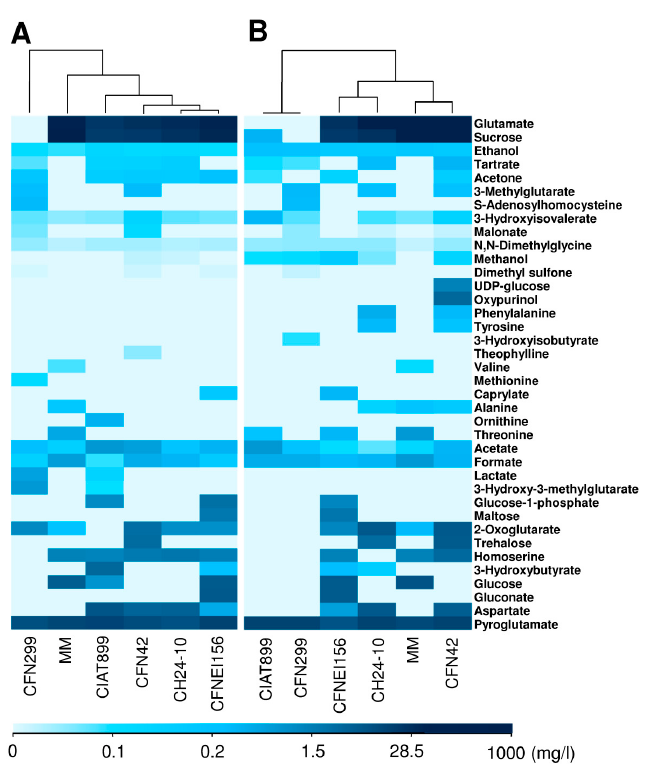
Figure 3. Heatmap and clustering trees based on the concentration profiles of the molecules found in supernatants either produced by rhizobial strains or from the MM (devoid of bacteria) at: ( A ) 24 h and ( B ) 50 h of growth.